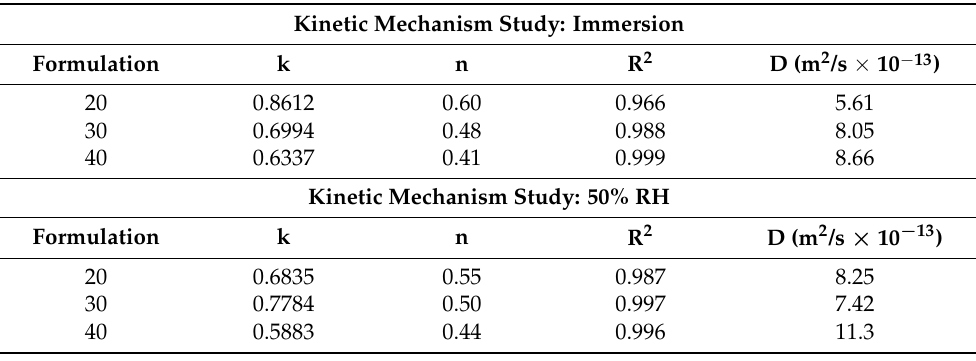
Table 2. Values of kinetic parameters k and n, and diffusion coefficient D of PP composites reinforced with hemp